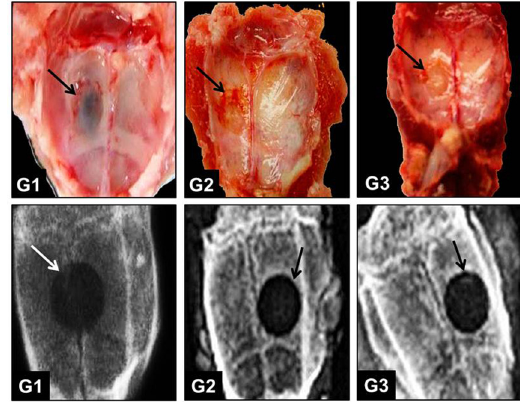
Figure 5. Inferior view after removal of the skullcap in the three groups studied (G1, G2, and G3). Note the defect area (arrow) without alterations and the presence of the implanted biomembranes in G2 and G3. Radiographic image of the superior view of the skullcap in the three groups studied (G1, G2, and G3). Observe the preservation of cranial anatomy and persistence of the experimentally induced bone defect. In G2 and G3, a radiopaque image is evident in the center of the defect, indicating the presence of the implanted biomembranes which were not reabsorbed during the experimental